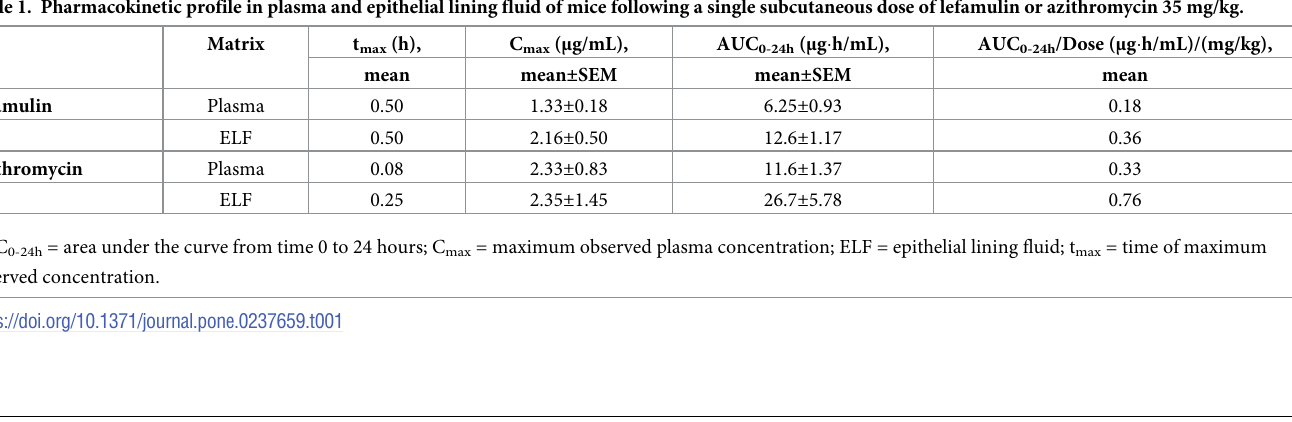
Table 1. Pharmacokinetic profile in plasma and epithelial lining fluid of mice following a single subcutaneous dose of lefamulin or azithromycin 35 mg/kg. Matrix Lefamulin Azithromycin